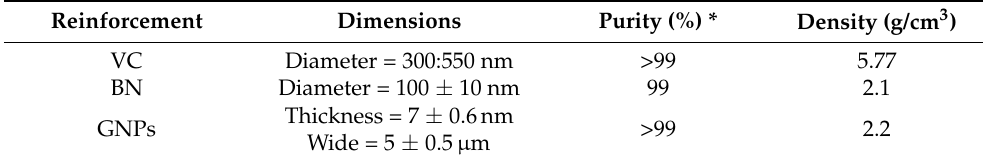
Table 2. Specifications of the used